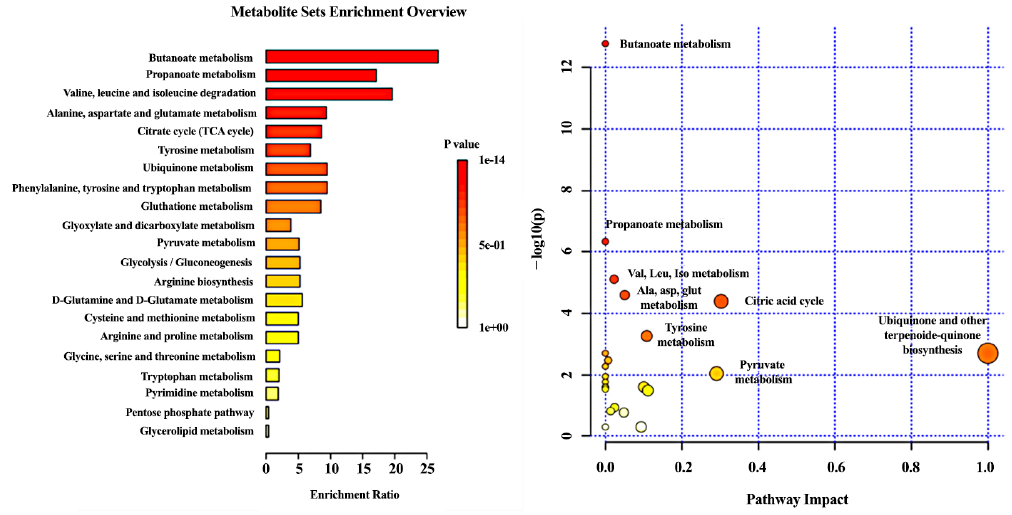
Figure 4. Enrichment analysis ( Left ) and pathway topology analysis ( Right ) of altered metabolic pathways in AD both obtained from MetaboAnalyst. In the pathway analysis diagram X axis indicates the impact of selected metabolites in the presented pathway while the Y axis shows level of enrichment of the